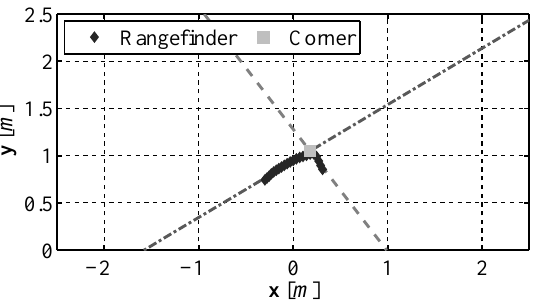
Figure 22. Corner identification using the modified RANSAC